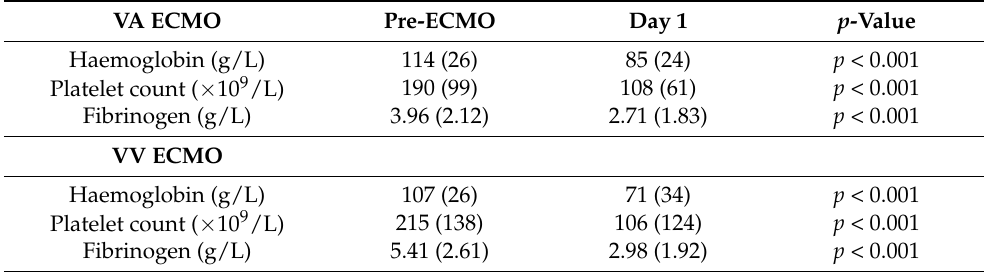
Table 3. Initial Pre-ECMO status to Day 0